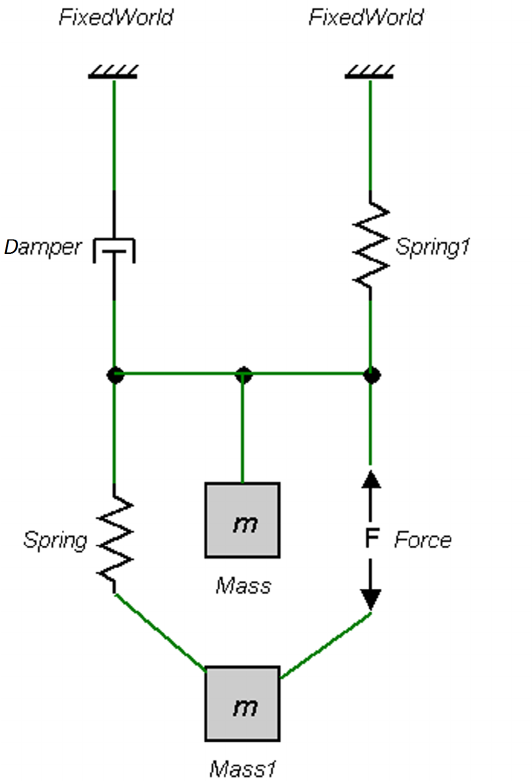
Figure 6: Mechanical model of the Bond Graph and electrical model shown in Figure 5-c and Fig- ure 4 respectively.